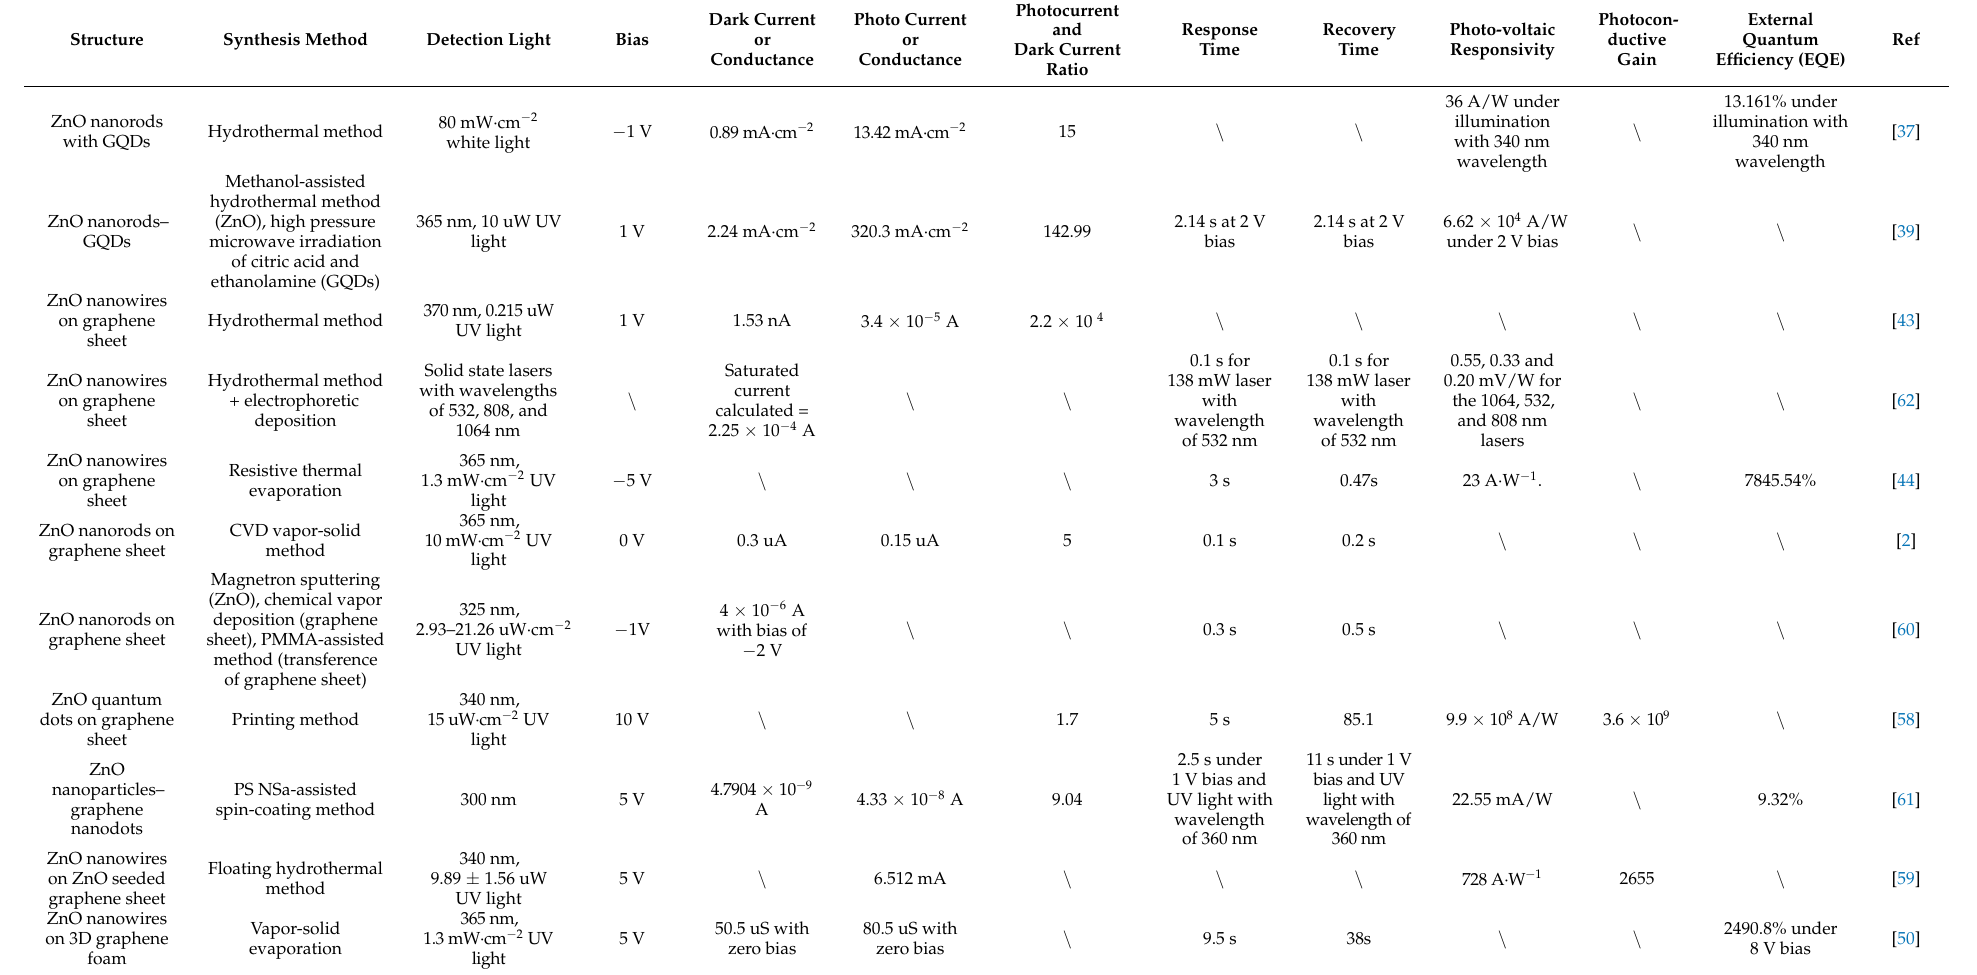
Table 2. Synthesis methods and photoelectric properties statistics of ZnO–graphene materials with different